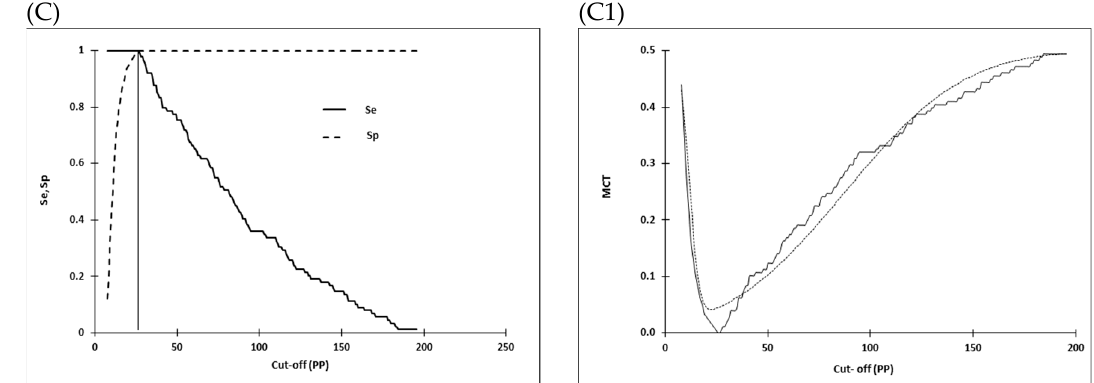
Figure 2. Optimization of cut-offs for Wag ( A ), nucleocapsid ( B ) and glycoprotein ( C ) ELISAs using the two-graph receiver operating characteristic analysis (TG-ROC). The insertion point of the sensitivity (Se, smooth line) and specificity (Sp, dashed line) graphs represents a cut-off PP value (13.53, 16.44 and 26.28, respectively) at which the highest and equivalent test parameters (Se = Sp) are achieved at 95% accuracy level. Using the misclassification cost term (MCT) option of the TG-ROC, at these cut-of values, the overall misclassification costs for WAg ( A1 ), NP ( B1 ), and GP ELISA ( C1 ) become minimal (0.0003, 0.0069, 0.0001, respectively) under assumption of 50% disease prevalence and equal costs of false-positive and false-negative results. The two MCT curves represent values based on non-parametric (dashed line) or parametric (smooth line) estimates of Se and Sp derived from data sets analyzed. Optimization of cut-off values was based on the non-parametric program option due to departure from a normal distribution of data analyzed. Cut-off values are expressed as percentage positivity (PP) of an internal positive serum control.